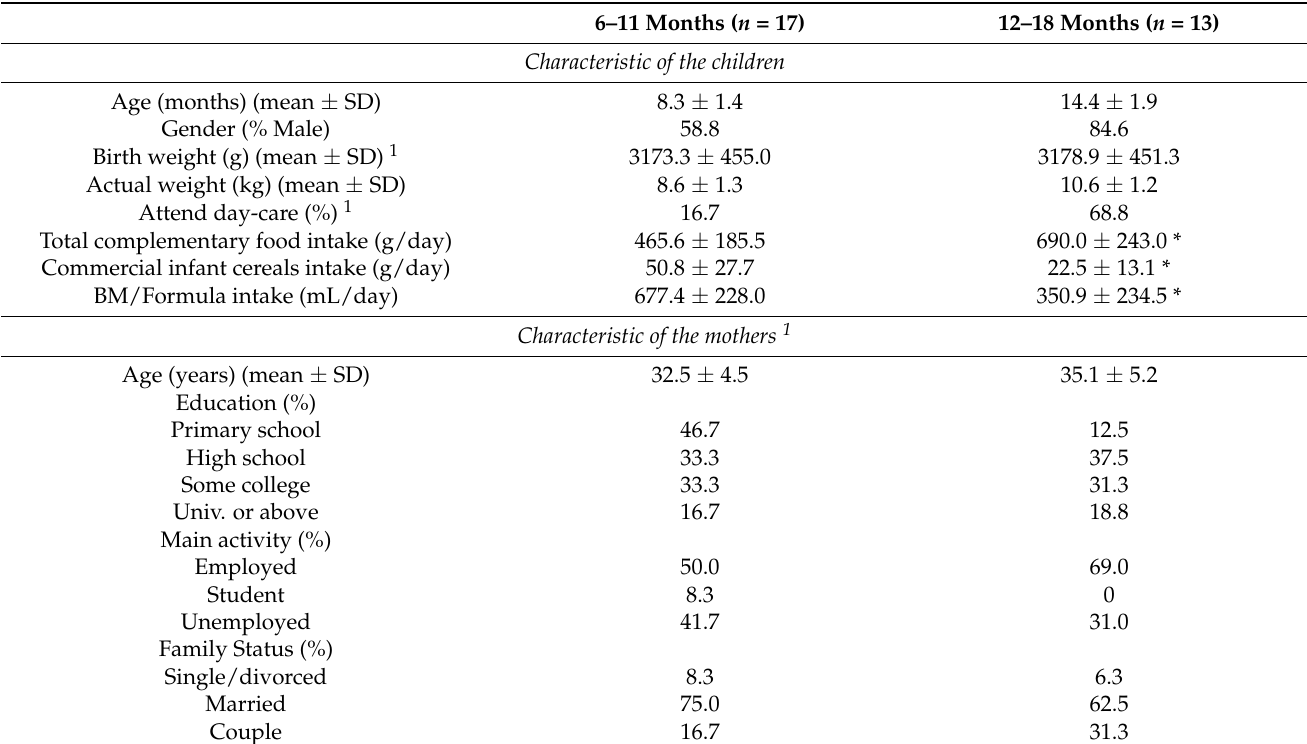
Table 1. Population